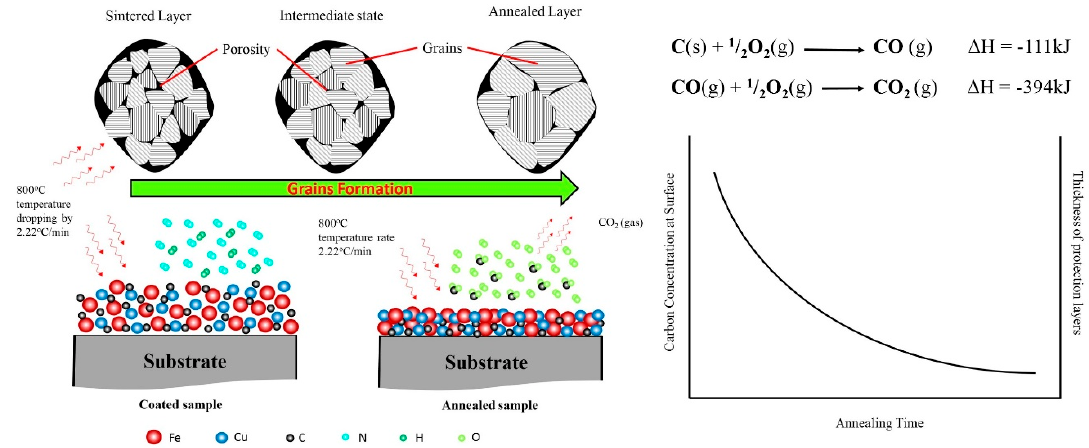
Figure 9. Internal mechanism observed during annealing of samples.